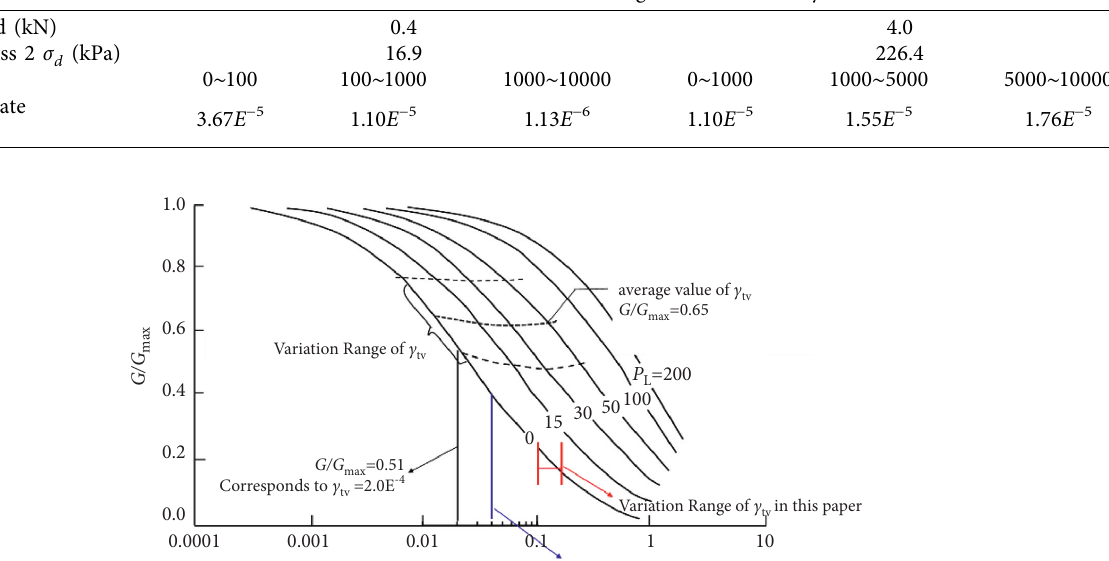
tv in the curve of relation between